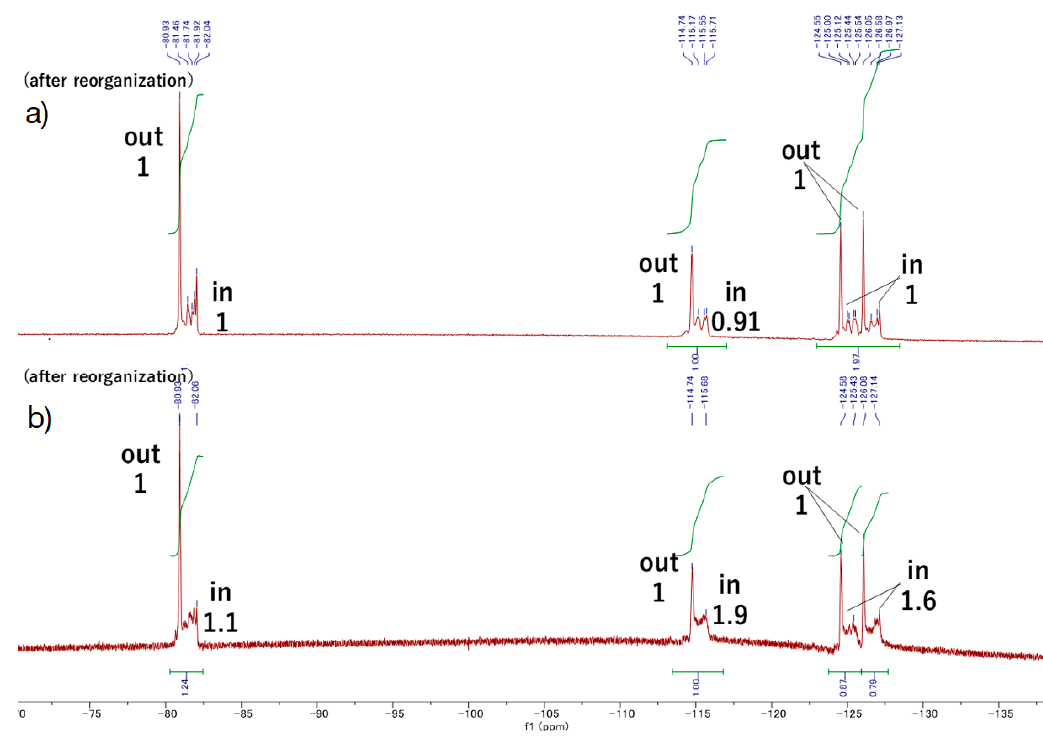
Figure 24. 19 F-NMR spectra (376.32 MHz, CDCl 3 , 298 K) of ( a ) reorganized sample of F9-GP1 , and ( b ) reconstituted sample composed of F9-GP1 and PEG8-GP1 (1:1).